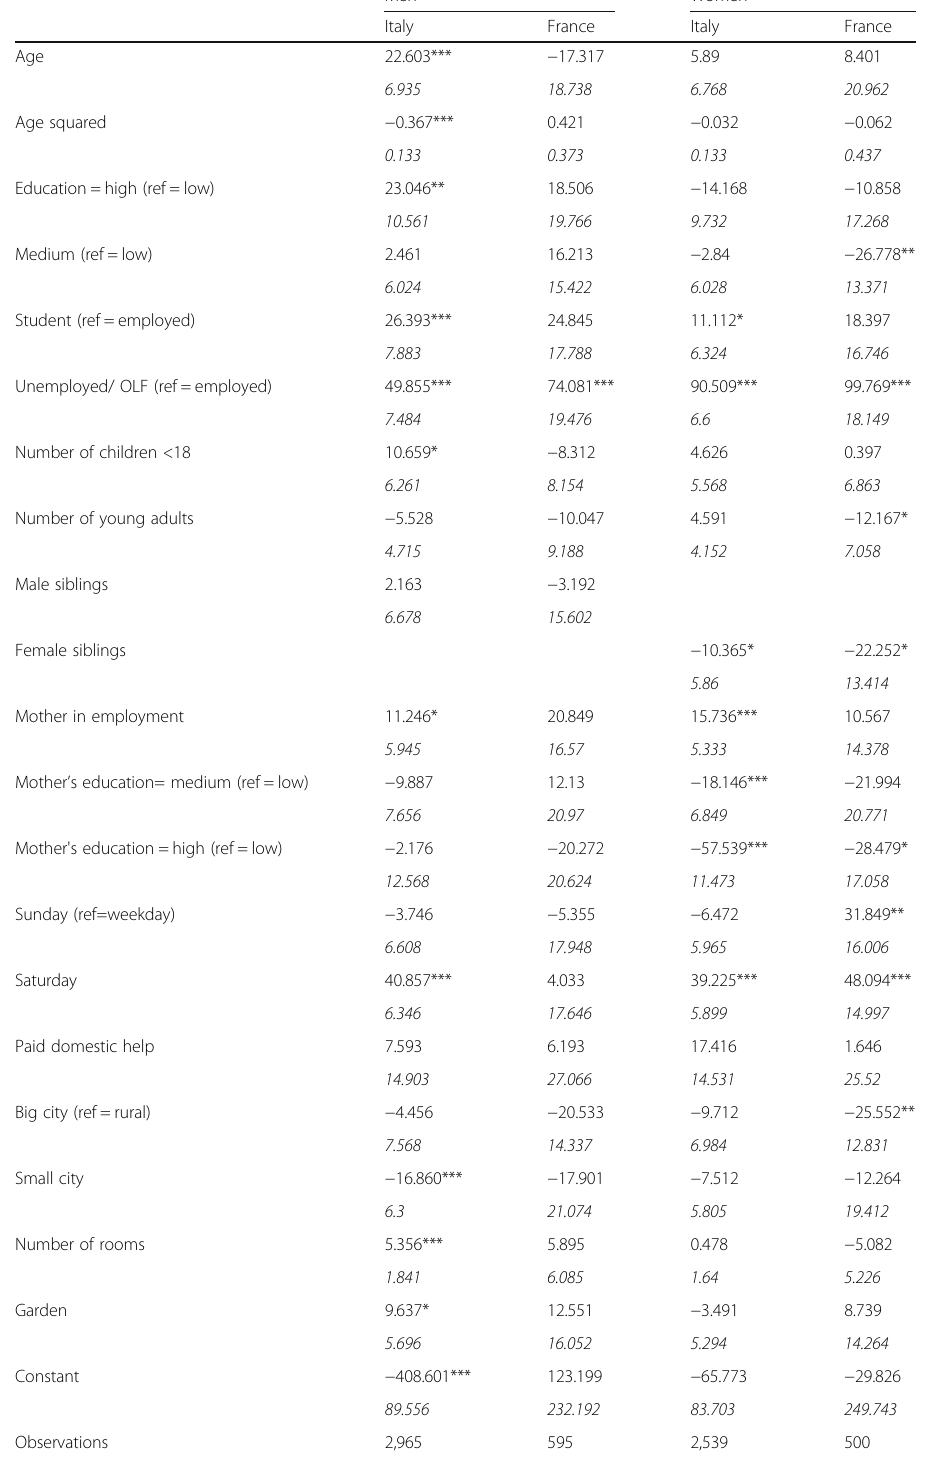
Table 4 Determinants of participation in domestic activities of young people living at parental home Men